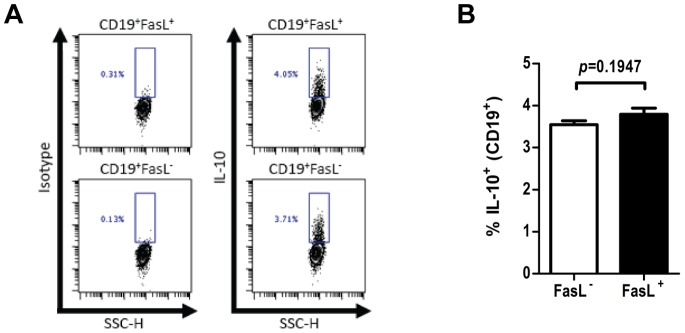
IL-10-producing B cells are not enriched in the FasL+ subset.FasL− and FasL+ splenic B cells from naïve mice were sorted by FACS and stimulated with PMA, ionomycin, and LPS in the presence of monensin for five hours. (A) Following stimulation, FasL− and FasL+ B cells were fixed and stained for intracellular IL-10. (B) Frequency of IL-10-producing B cells (mean ± SEM) among CD19+FasL− and CD19+FasL+ subsets.